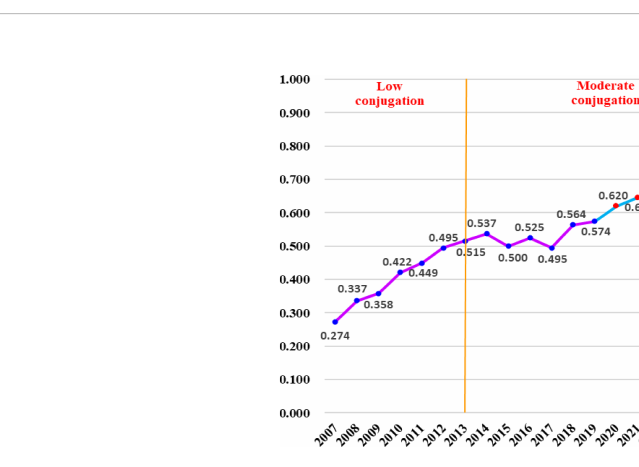
FIGURE 6 Trend prediction of conjugate degree of Marine Composite System in Shandong Province.